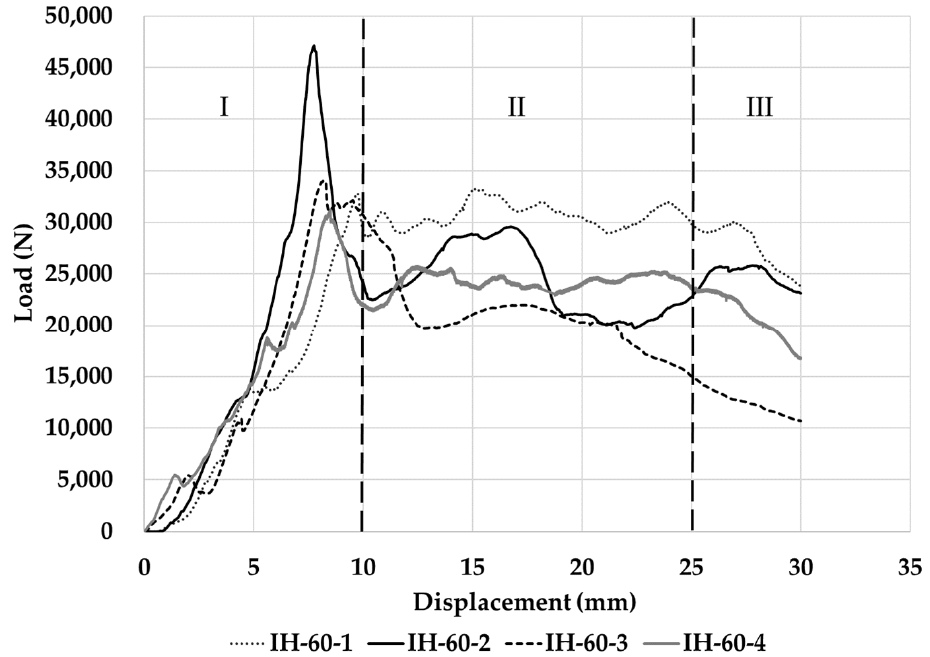
Figure 5. An example of axial crushing load-displacement curves of all four samples IH-60 config- uration.